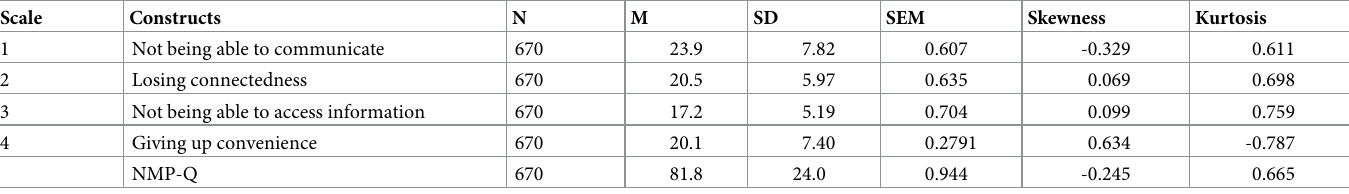
Table 5. Descriptive statistics of students’ scores with the NMP-Q scale ( N =